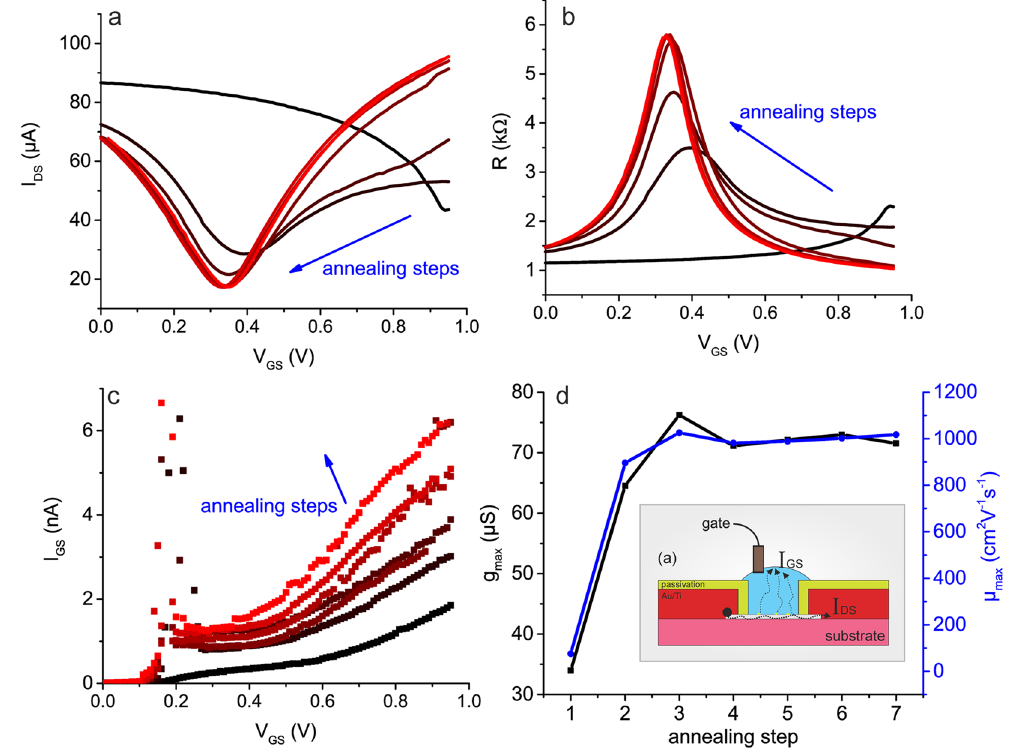
Figure 2. The evolution of the I DS -V GS ( a ) and R GS -V GS ( b ) curves over consecutive annealing steps. ( c ) The dependency of the gate leakage current on the V GS . ( d ) The evolution of the GFET transconductance and mobility over the annealing cycles. The inset gives the proposed mechanism of current-induced annealing of the graphene sheet under liquid physiological conditions in schematic